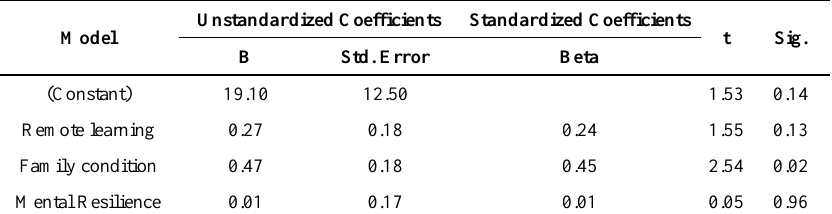
Table 8. The Results of Coefficients